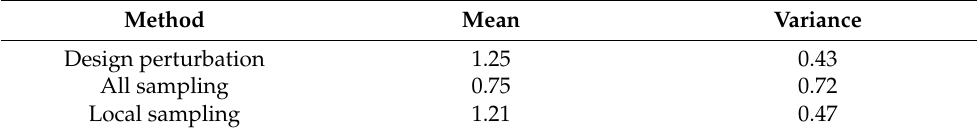
Figure 10. ( a ) The design perturbation model histogram, ( b ) perturbation of all sampling histograms, and ( c ) perturbation of local sampling histogram. Table 1. Statistical analysis of different methods of the target area.